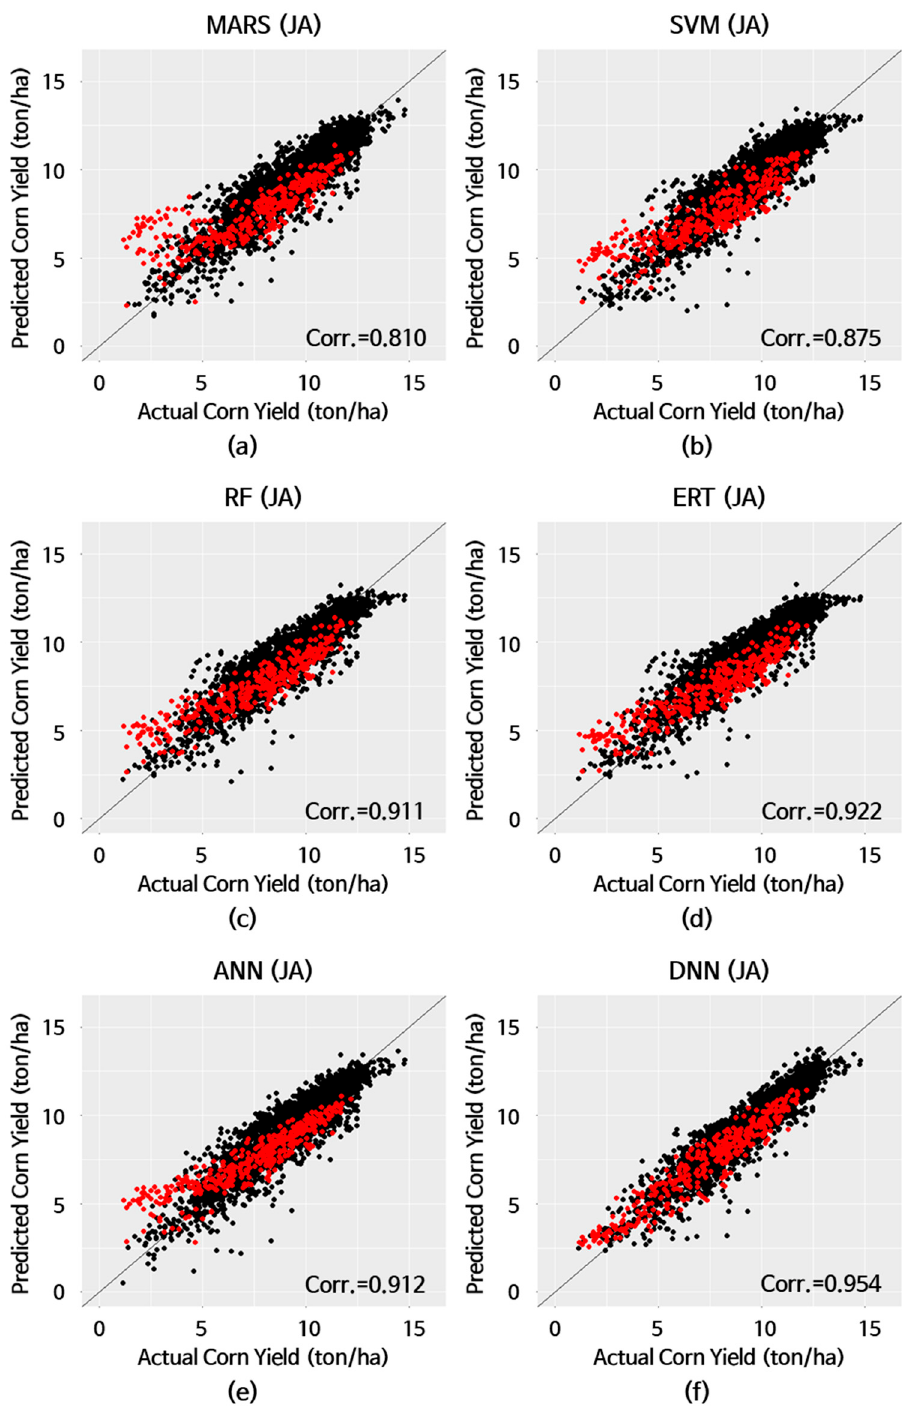
Figure 5. Actual and predicted corn yields for 2006–2015. Red dots, 2012 data under drought conditions; black dots, all other years. ( a ) Multivariate adaptive regression spline (MARS); ( b ) Support vector machine (SVM); ( c ) Random forest (RF); ( d ) Extremely randomized tree (ERT); ( e ) Artificial neural network (ANN); ( f ) Deep neural network (DNN)